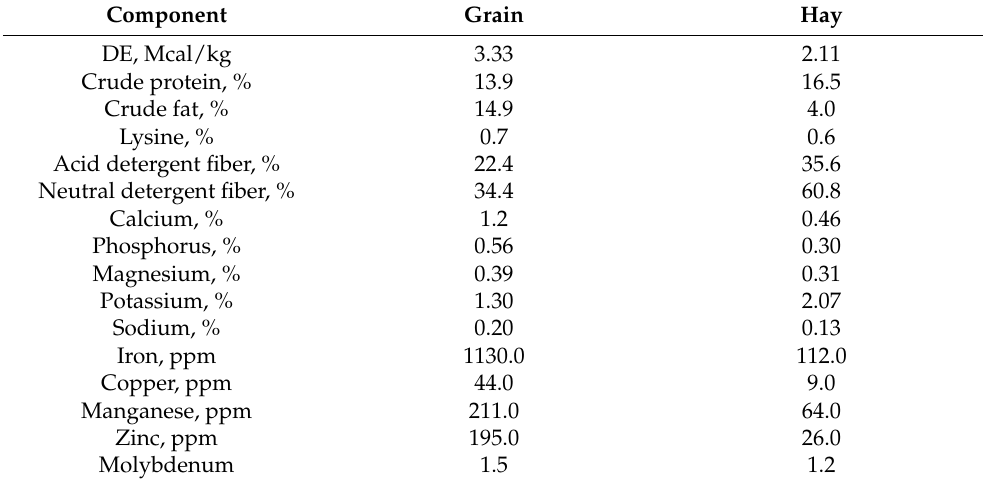
Table 1. Chemical composition of feedstuffs; dry matter